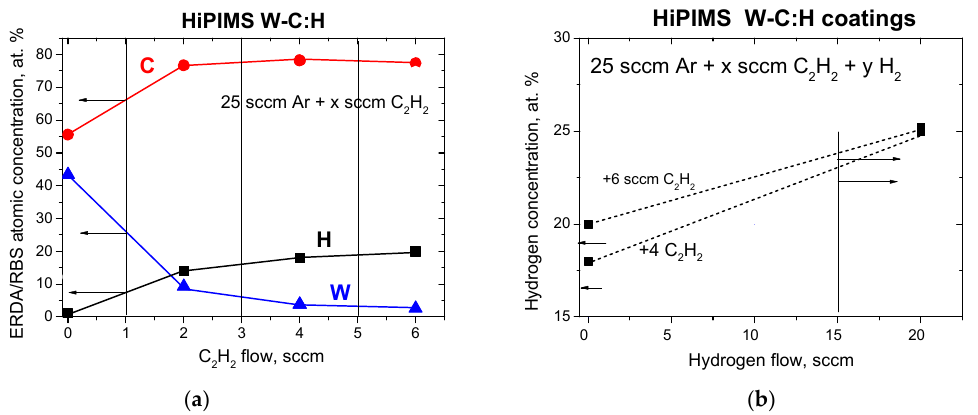
Figure 2. Elemental compositions of analogous HiPIMS W-C:H coatings by RBS/ERDA for the estimation of the composition in the current W-C:H coatings produced ( a ) without hydrogen additions and ( b ) at simultaneous acetylene and hydrogen additions (reprinted with permission from Ref. [22], 2020, Elsevier. The vertical lines and arrows indicate reactive gas additions and values used for the estimation of composition in the current set of W-C:H coatings produced with 3 and 5 sccm C 2 H 2 and 0 and 15 sccm H 2 additions, respectively.